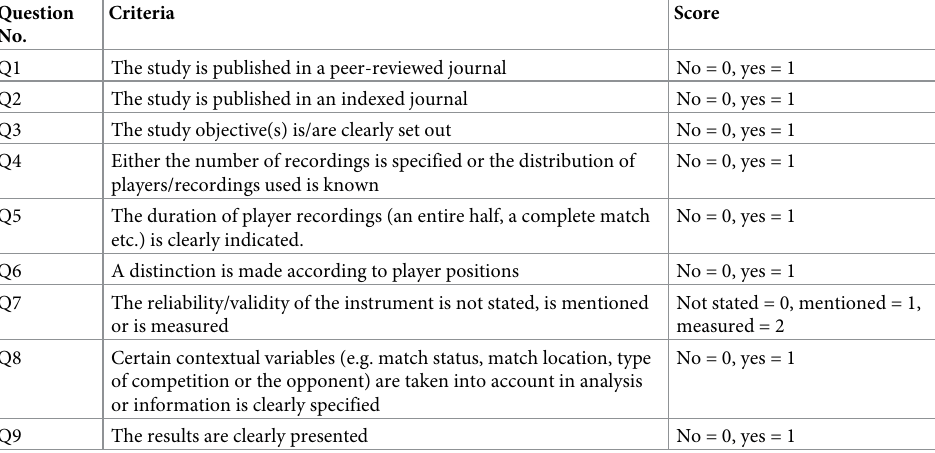
Table 1. Methodological quality criteria for selected